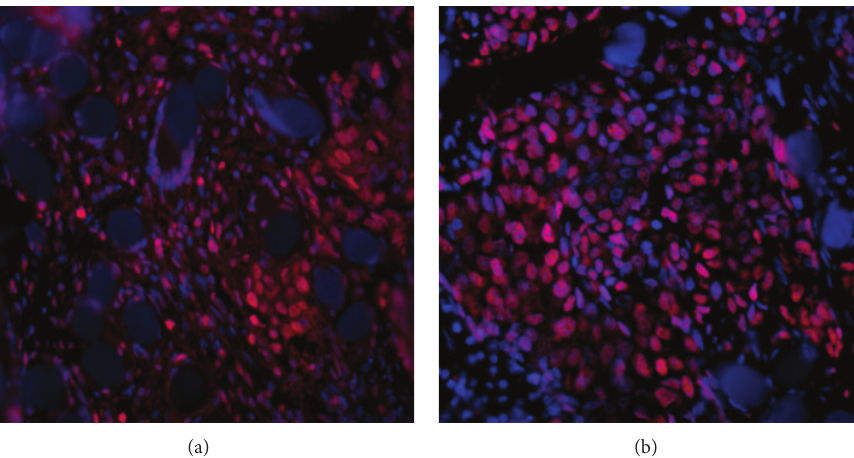
Figure 9: Dermal-like tissue reconstructed in vitro . Cells, visible thanks to the red staining of the nuclei, can be seen inside the collagen-based scaffold and appear to be organized in layers. (a) Un-treated control after 9 days from the beginning of the experiments; (b) treated control at nine days.